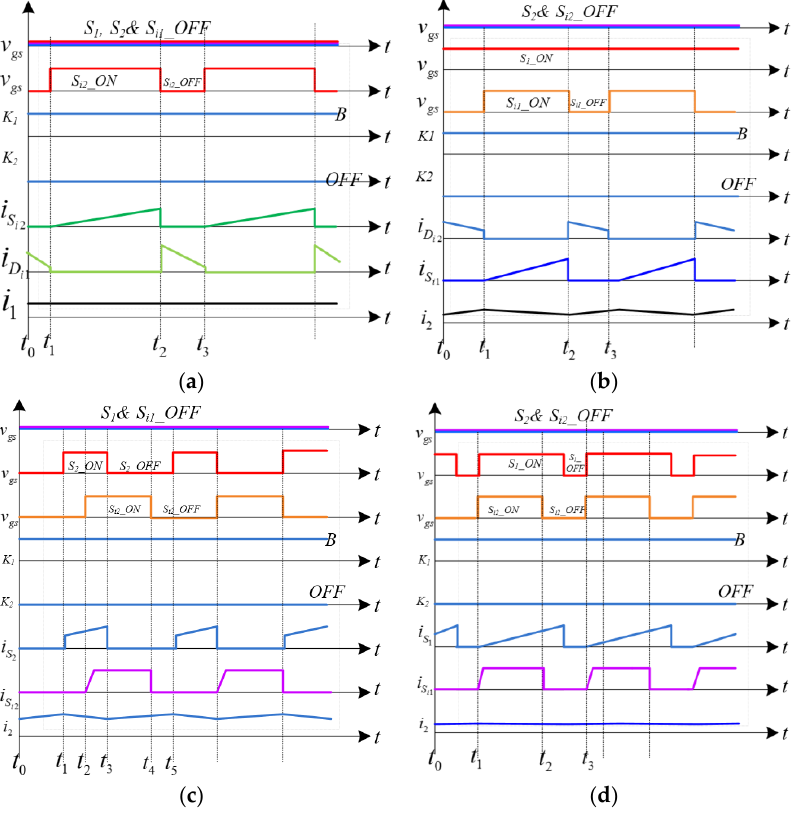
Figure 8. The key wave forms of the proposed converter in isolated mode: ( a ) forward mode; ( b ) reverse mode; ( c ) high-conversion-ratio step-up mode; and ( d ) high-conversion-ratio step-down mode.